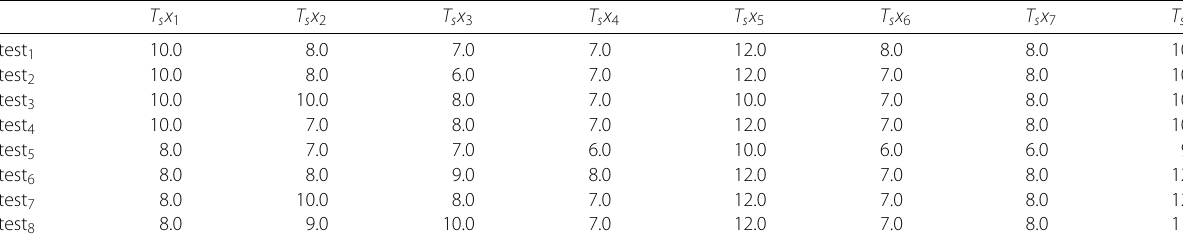
Table 4 Convergence time (sec) for the robotic tower crane’s state